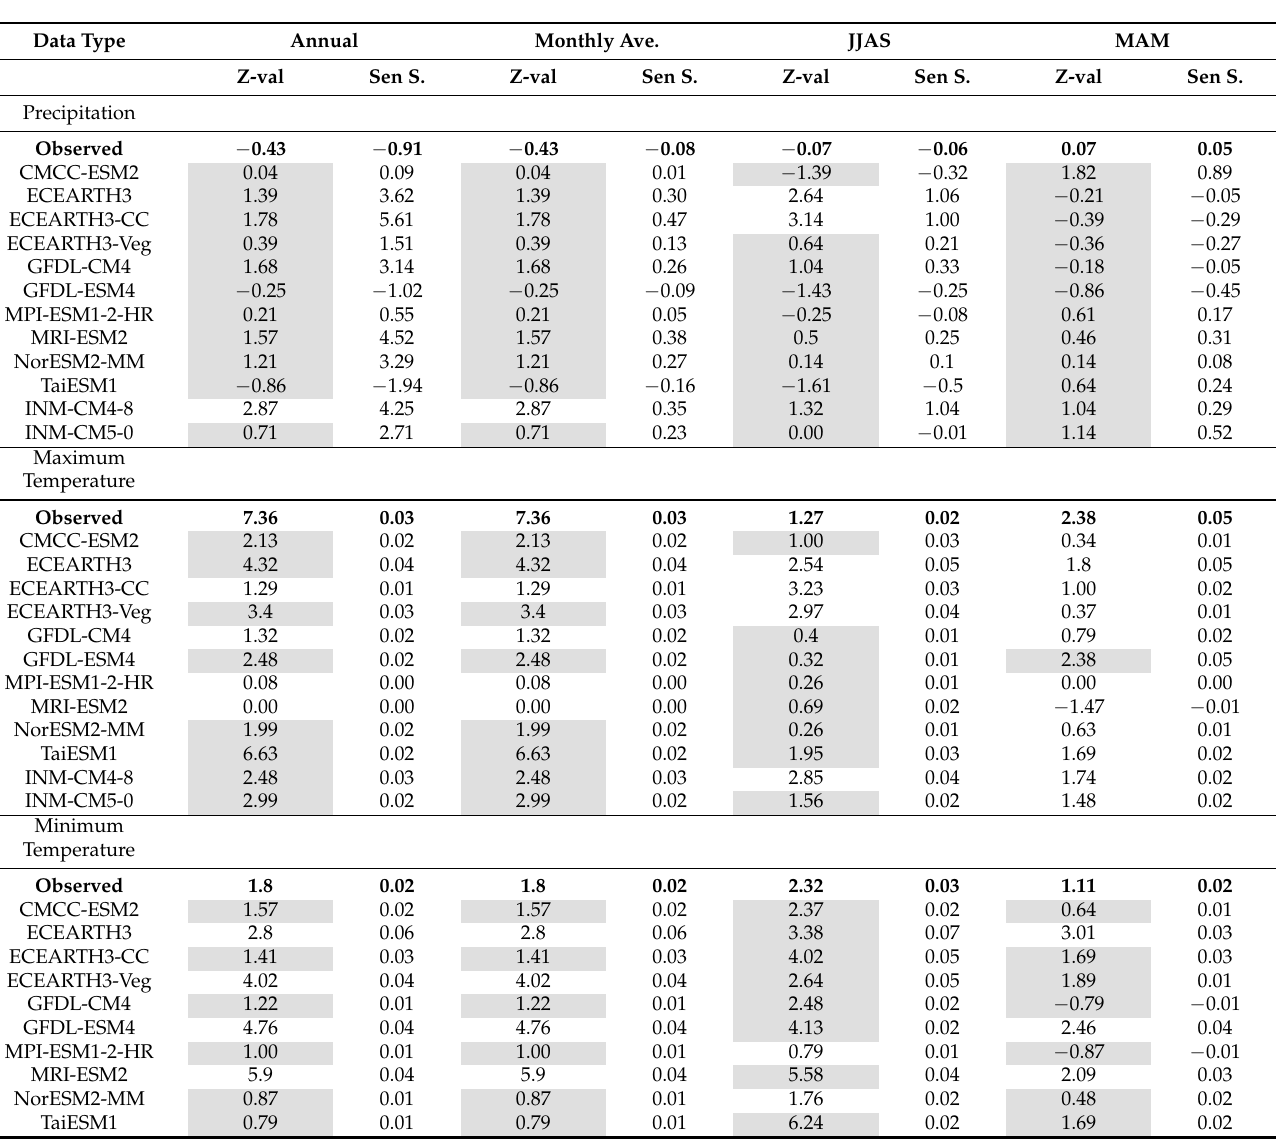
Table 4. Results of the trend analysis for all three climatic variables across the four time steps for the observed and climate model